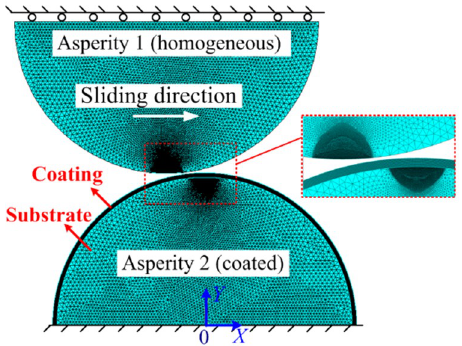
Figure 2. Finite element model.